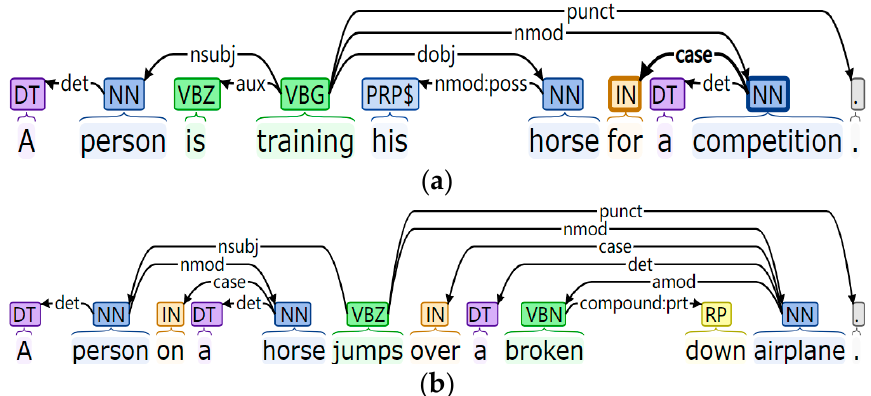
Figure 5. Dependency syntax. ( a ) Presupposition sentence; ( b ) hypothetical sentence.